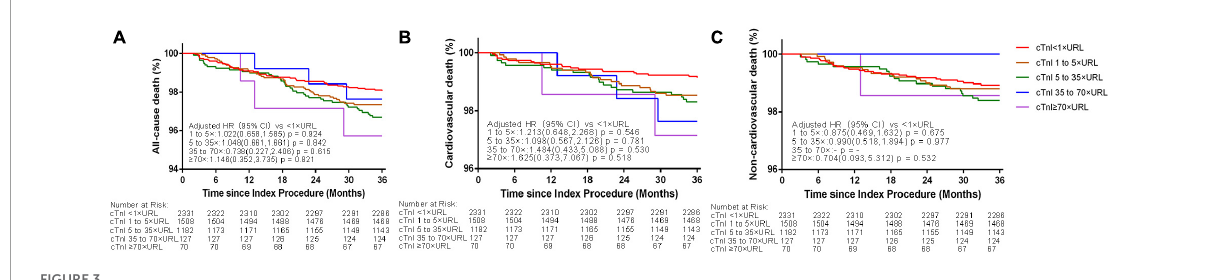
FIGURE3 Three-year Kaplan–Meier curves for all-cause (A) , cardiovascular (B) , and non-cardiovascular death (C) according to different thresholds of post-PCI peak cTnI values in patients with elective PCI. URL, upper reference limit; cTnI, cardiac troponin I.